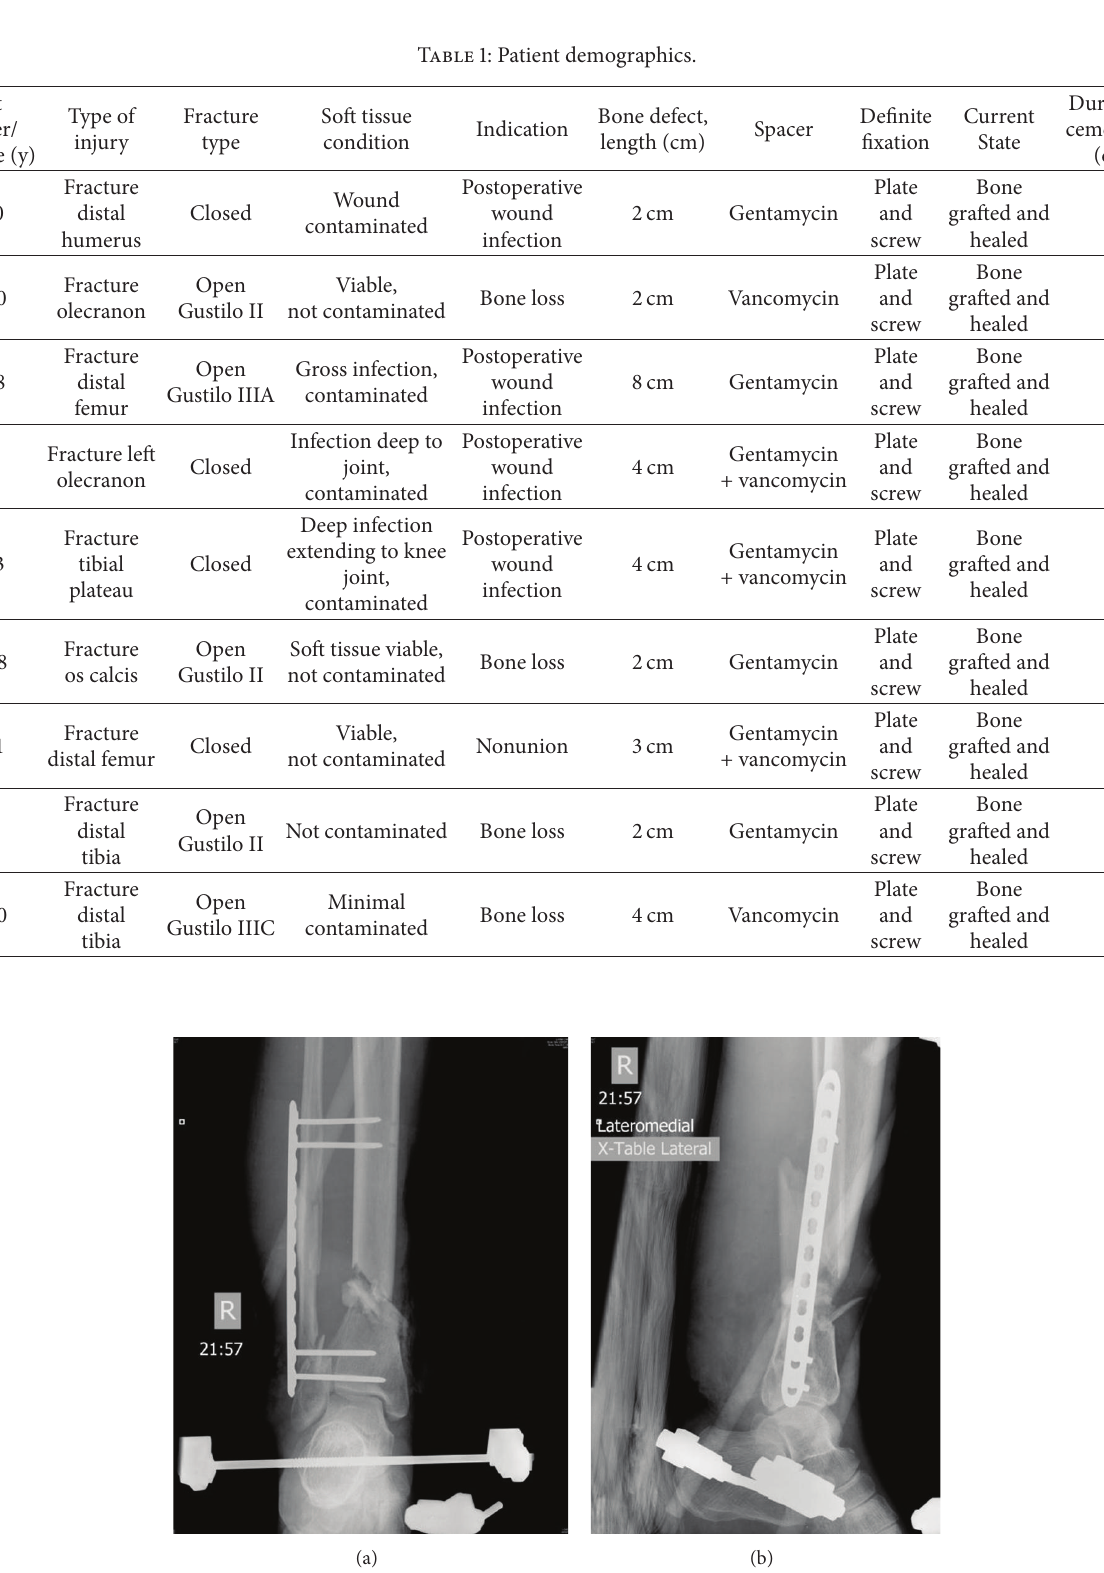
Figure 1: AP (a) and lateral (b) radiographs of an open fracture right distal tibia Gustilo Type IIIA at admission. It was initially debrided, stabilized, and shortened with an external fixator, leaving a defect over right distal